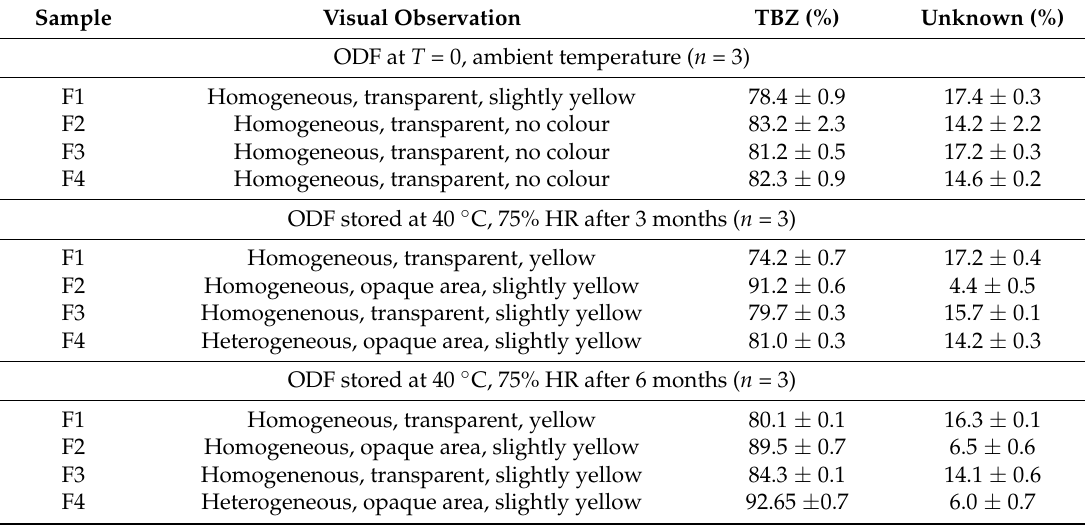
Table 3. Overview of visual observations and % of TBZ ( t r 2.9–3.3 min) and unknown compound ( t r 3.7–4.5 min) in LC-MS analyses at T = 0 and after 3 and 6 months of stability. LC-MS separation conditions are the same as in Reference [14] (see Section